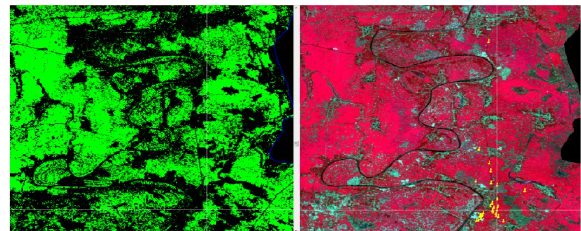
Figure 7. Mean DN values of different crops as seen in multi- spectral data (Green: Jute and red& Blue: Other Crop)